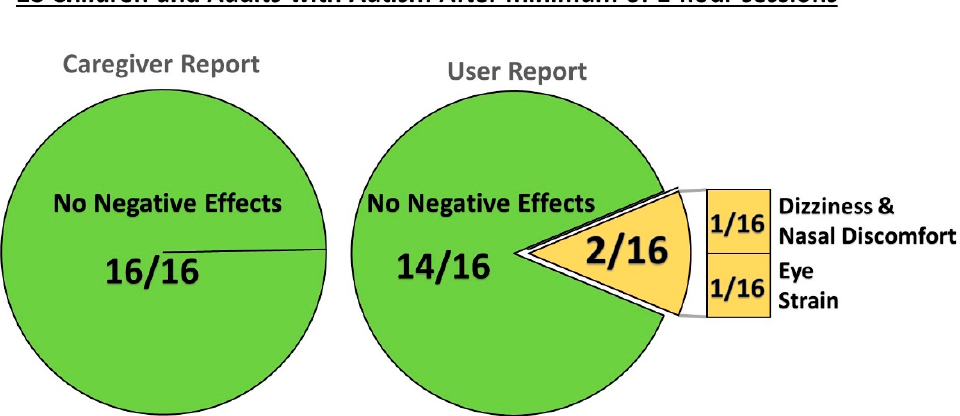
Figure 8. All Reported Negative Effects of the Empowered Brain System. Two users reported a total of three negative effects. One user experienced dizziness and nasal discomfort, and one user experienced eye strain. Caregivers reported that they observed no negative effects on users.